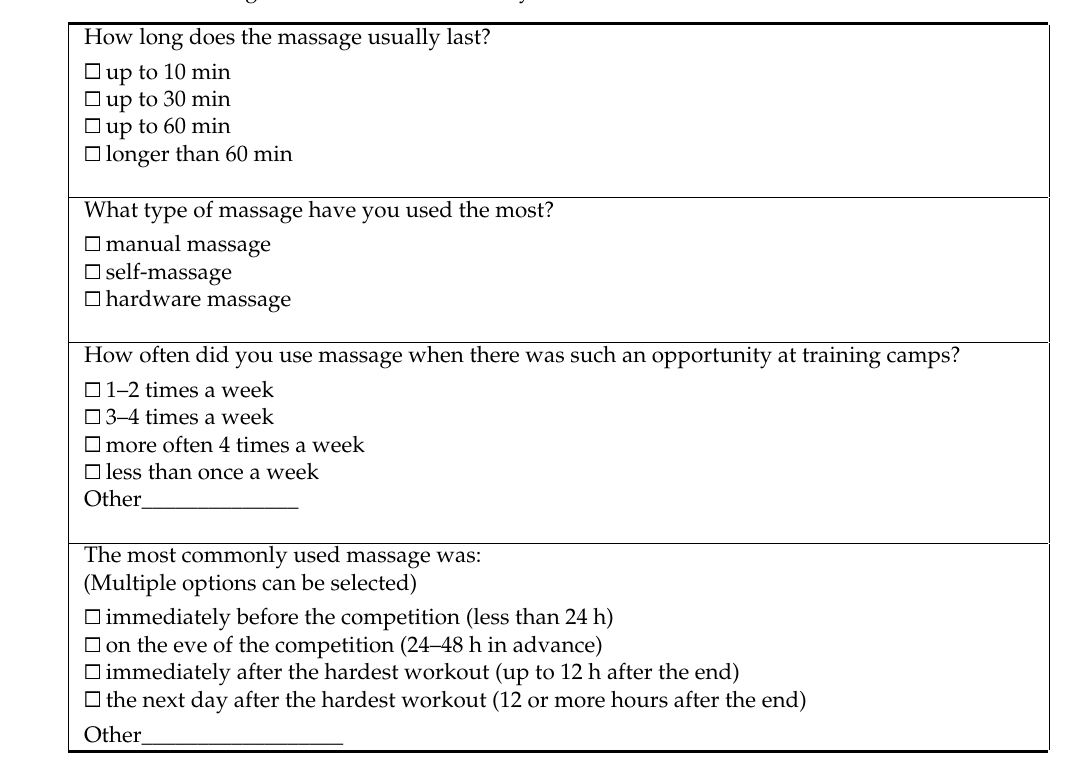
Table 4. The questionnaire “The Use of Massage as a Recovery Method Among Highly. Competitive Athletes Exercising Endurance in the Recovery of